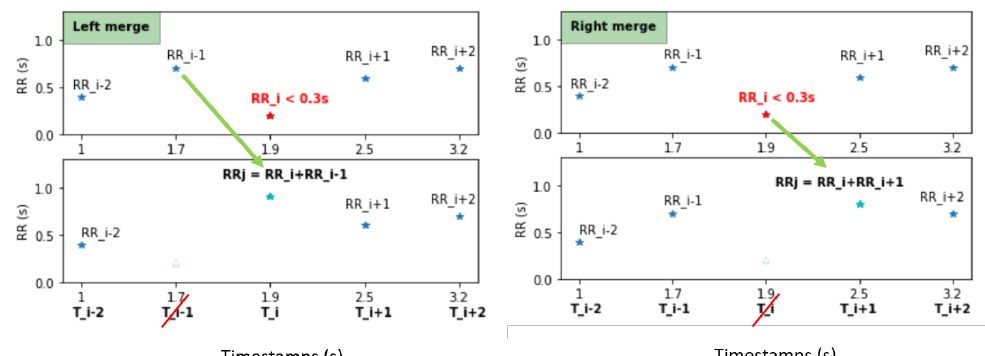
Figure 3. In the right merge, RR i < 0.3 s is added to the next value, and RR i and its timestamp T i are deleted. The new value RR j = RR i + RR i + 1 = T i + 1 − Ti − 1. In the left merge, RR i is added to RR i − 1 and placed at T i , and RR i − 1 as well as its timestamp T i − 1 are deleted to respect the equality abscissa-ordinate. The new value RR j = RR i + RR i − 1 = T i − Ti − 2. The subscript i is used to index initial RR intervals and the new value is referred to as RR j